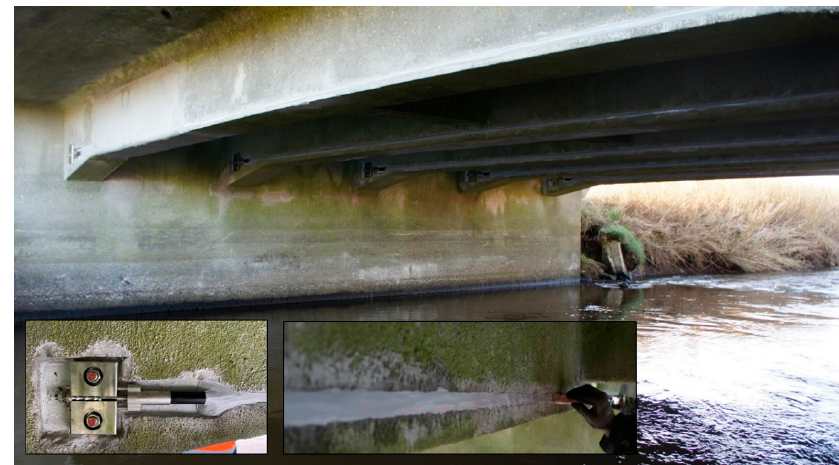
Figure 17. The final result of the applied strengthening. Photograph by S&P.